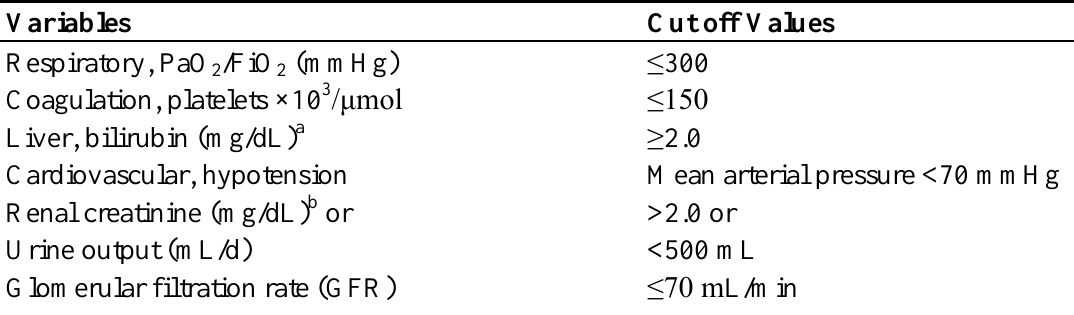
Table 2. The cut-off values for organ